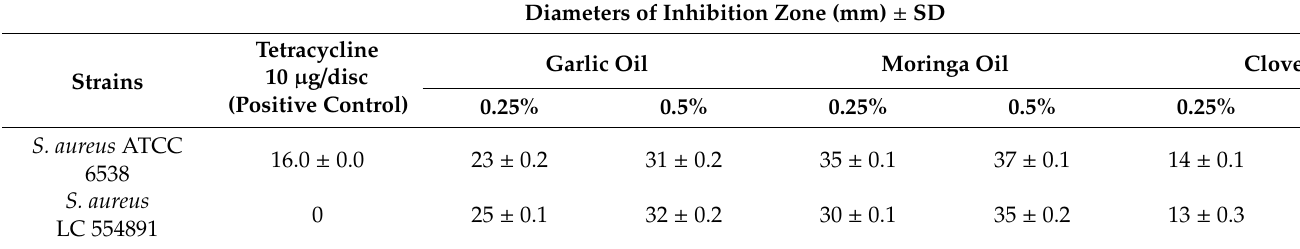
Table 2. The e ff ect of some essential oils such as garlic, moringa, and clove oils against the selective S. aureus strain LC 554891 by using a disc di ff usion method compared to tetracycline (10 µ g /